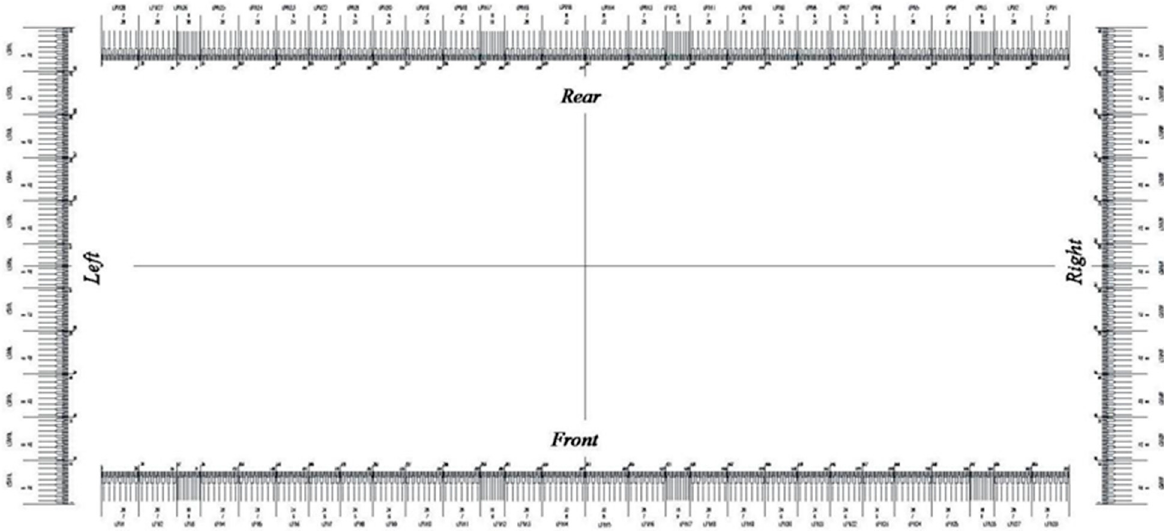
Figure 8. Schematic of Distribution of Water Cooled Wall Orifice Circles on Four Walls of Lower Furnace.